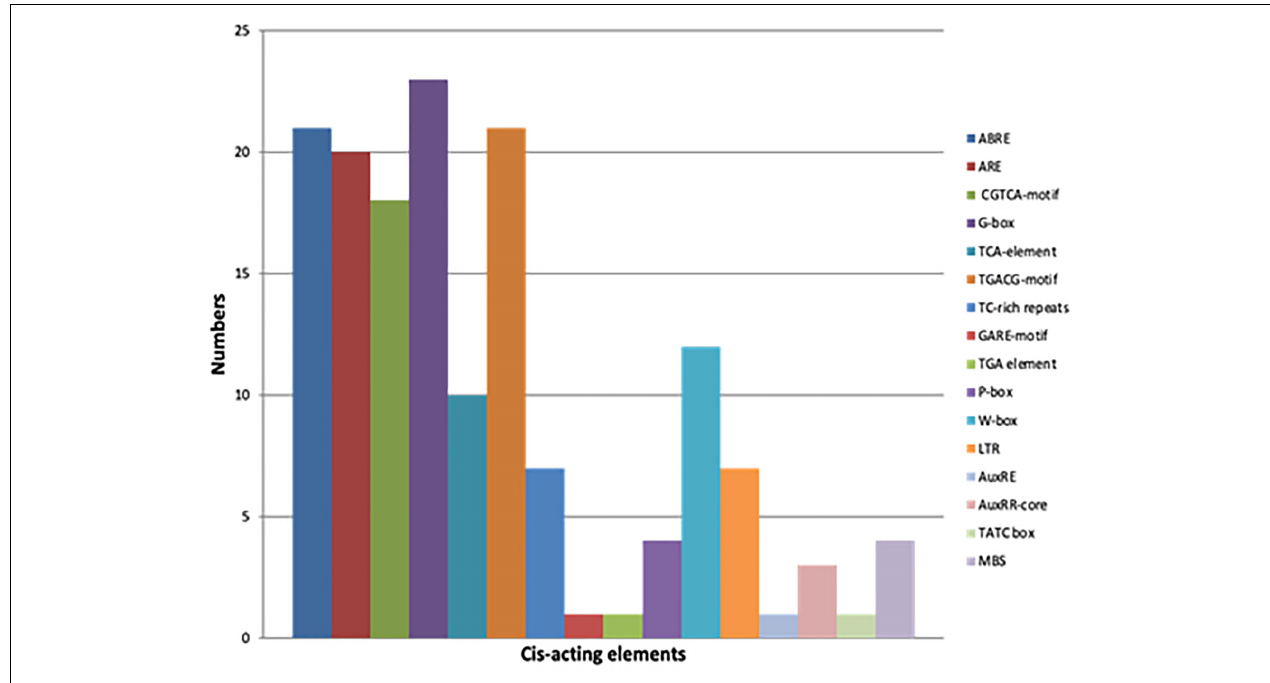
FIGURE 8 | The graphical representation of different cis- acting elements present in the promoter sequences of GmCMLs. Different colors depict different cis- acting elements [ABRE – Abscisic acid responsiveness, ARE –Anaerobic induction (wounding), CGTCA motif – Jasmonate responsiveness (MeJA), TCA-element – Salicylic acid responsiveness, TGACG-motif - Jasmonate responsiveness (MeJA), TC-rich repeats –defense and stress response, GARE-motif – Gibberellin responsiveness, TGA element – Auxin response, P Box - Gibberellin responsiveness, W-Box - Stress inducible, LTR – Low temperature response, AuxRE- Auxin responsive element, AuxRR-core - Auxin responsive element, TATC box - Gibberellin responsiveness and MBS – Drought